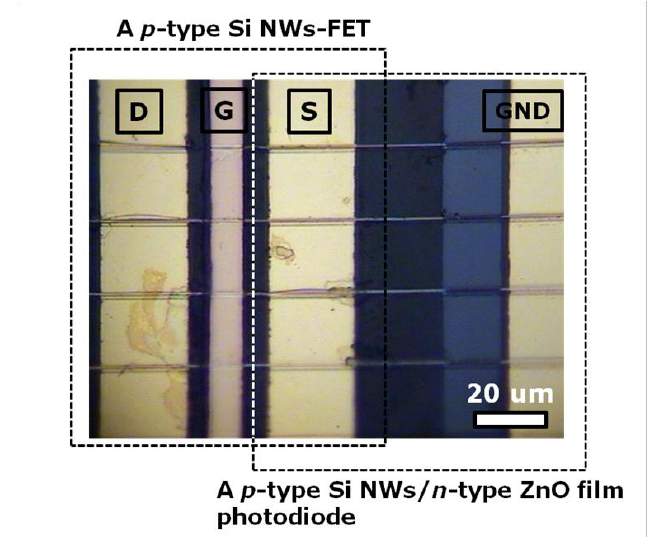
Figure 2. The optical top-view image of the laterally coupled